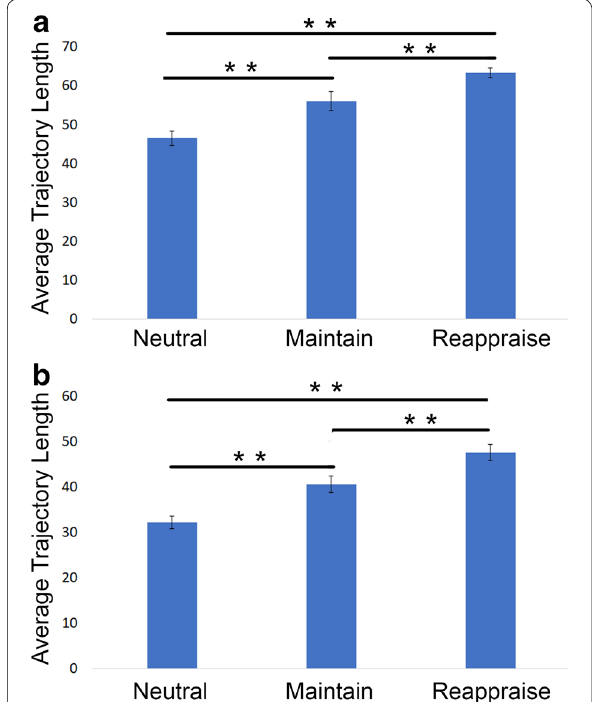
Fig. 6 Average trajectory length of each condition in 2-D isomap spaces, both k-nearest neighbor approach ( a ) and the epsilon-based approach ( b ). In k-isomap, the average length in Neutral : 46.49 ± 1.85 , Maintain : 55.99 ± 2.42 , Reappraise : 63.30 ± 1.26 ; in ε -isomap , the average length in Neutral : 32.21 ± 1.37 , Maintain : 40.62 ± 1.82 , Reappraise : 47.61 ± 1.74 . Both suggest that Thought Chart travels in longer distance in more complex task conditions. Significant findings 0.01 ) in group t test are indicated with ** ( p < and * p <